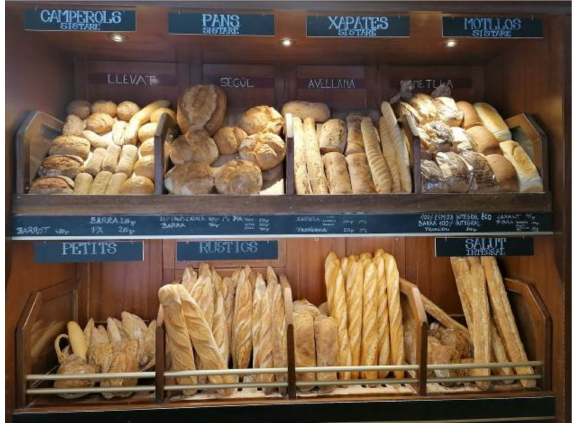
Figure 2. Bread products sold at bakeries (own source).